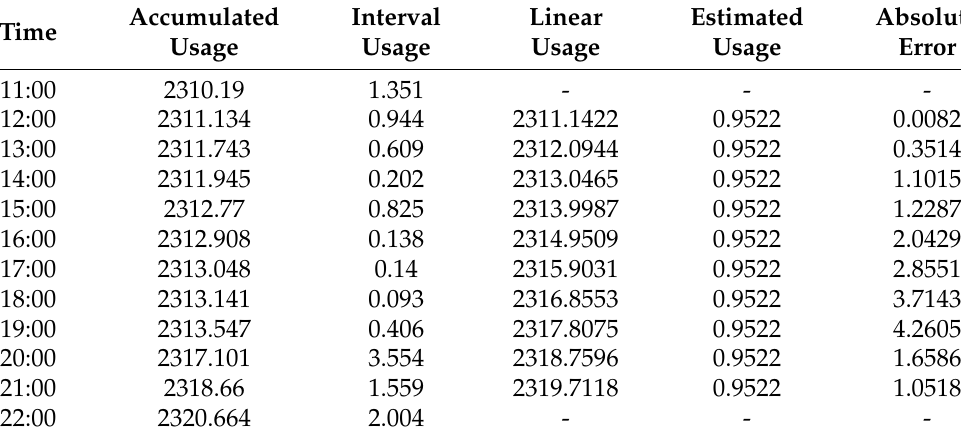
Table 2. Data for linear interpolation-based